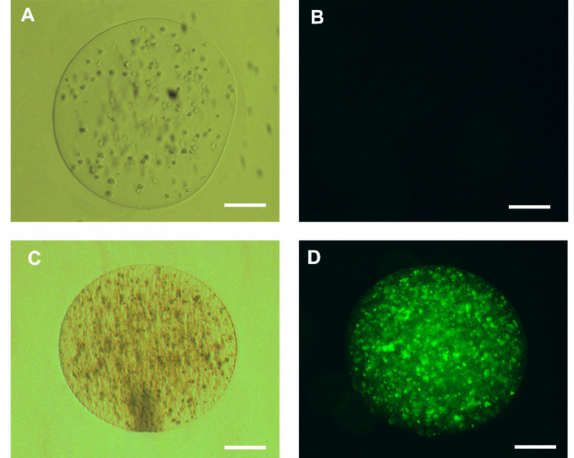
Figure 6. Representative cell viability test of human hepatocellular carcinoma cells (HepG2) cells encapsulated in 3% sodium alginate; ( A ) live encapsulated hepatocytes maintained for 24 h in Roswell Park Memorial Institute (RPMI) medium with 10% fetal bovine serum (FBS); ( B ) HepG2 cells encapsulated in 2 µ M YO-PRO1 solution. The living cells do not display any dye labeling, represented by the absence of fluorescence inside the capsule; ( C ) dead encapsulated HepG2 cells maintained for 24 h in RPMI medium with 10% FBS visualized on the clear field and ( D ) HepG2 cells displaying fluorescence after labeling with 2 µ M of YO-PRO1; 200 µ m